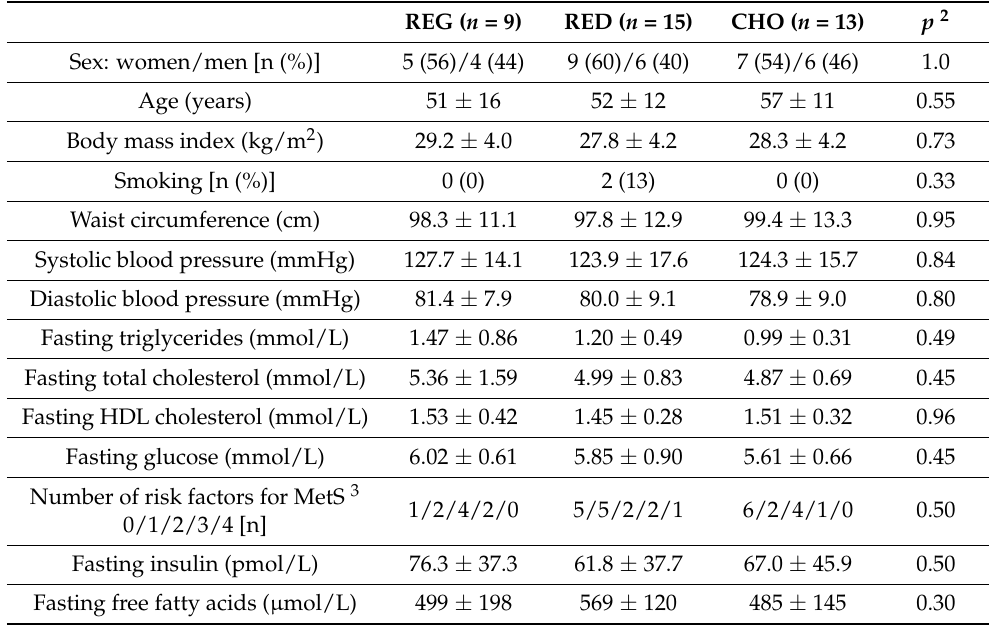
Figure 1. Flow chart. CHO, carbohydrate-rich meal; RED, reduced-fat cheese; REG, regular-fat cheese. Table 2. Characteristics of the 37 participants who completed the test meal 1.